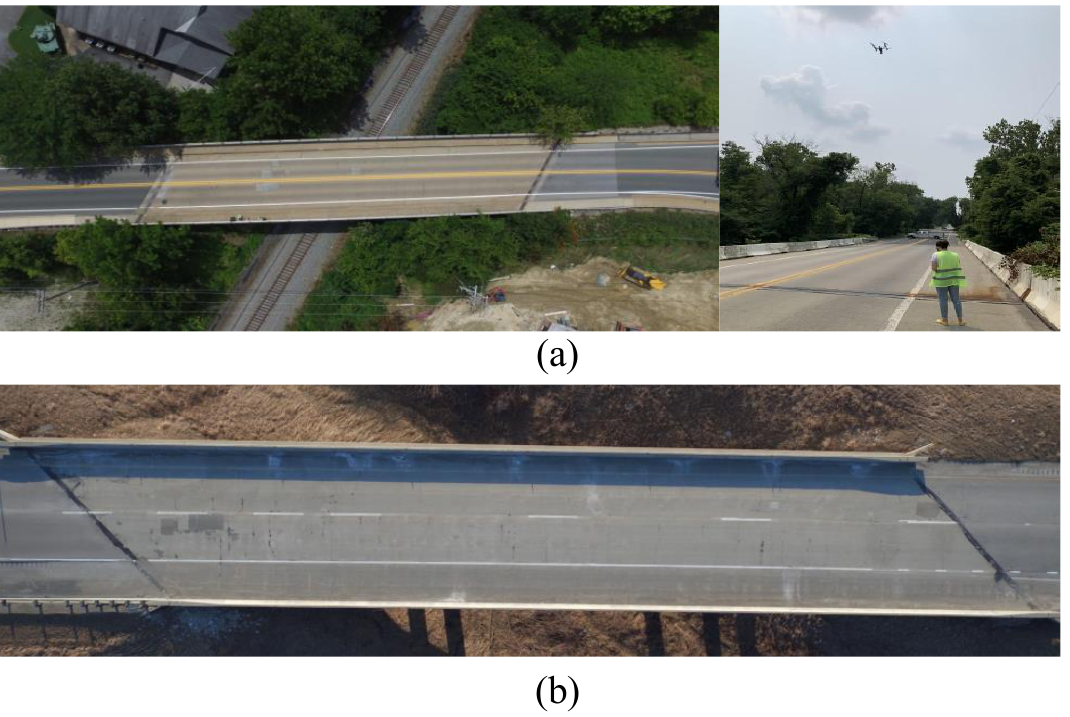
Figure 8. Field data collection location: ( a ) Apple Rd bridge; Bridge ID: 1696-360; GPS location: 39°40 ’ 44.1 ” N 75°45 ’ 50.5 ” W, ( b ) US-77 Bridge, Bridge ID: S077-05693R; GPS location: 40°44 ’ 23.9 ” N 96°43 ’ 00 ” W.